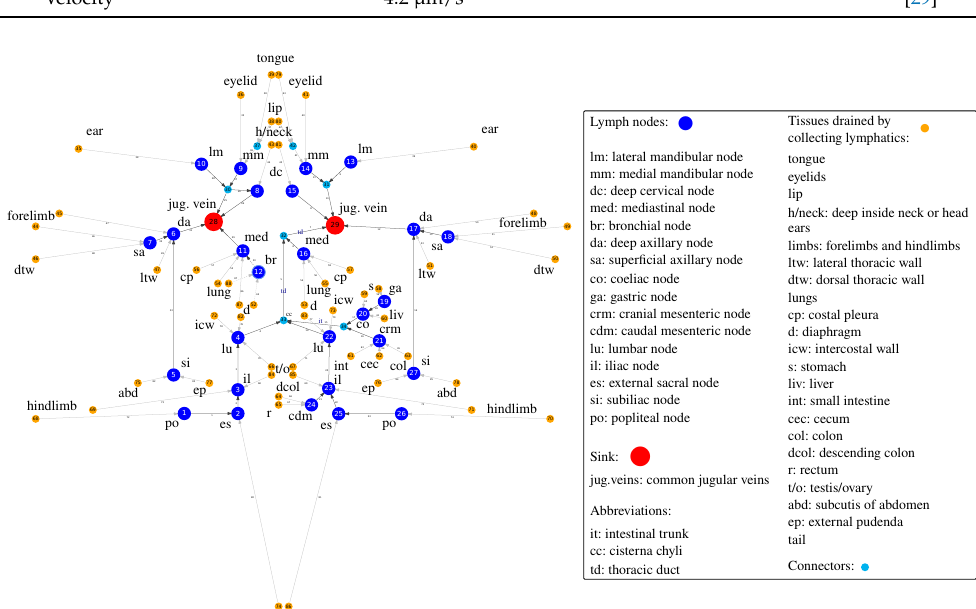
Figure 1. Oriented graph of the murine lymphatic system based on the anatomic data with 88 vertices and 87 edges. The vertices of the graph belong to four groups as detailed in the legend box: (1) lymph nodes (large blue), (2) outlet vertices with out-degree deg + = 0 corresponding to the sink into jugular veins (red), (3) connectors, i.e., the confluences of lymphatic vessels (light blue), (4) inlet vertices with in-degree deg − = 0 corresponding to the collecting lymphatics of various body tissues (orange). The vertex IDs and edge IDs are enumerated arbitrarily for correspondence with the matrix representation of the graph in Figure 2. The presented graph is specified in the CSV files containing the vertex and edge lists in Supplementary